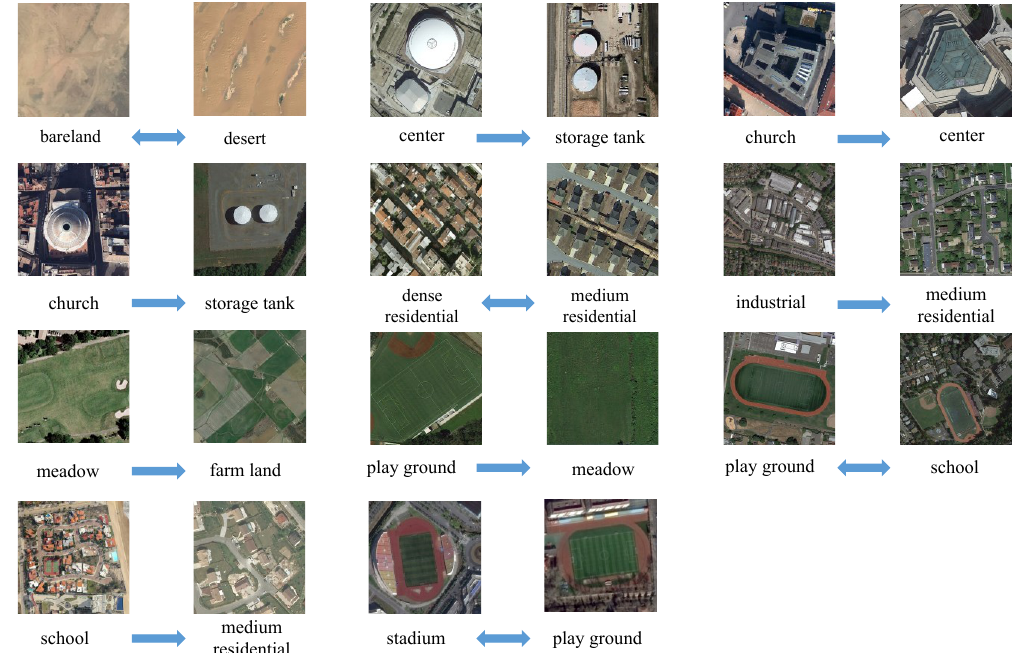
Figure 6. Examples of asymmetric noise mapping scenes in the AID dataset. Pseudo-Labeling noise : Pseudo-labeling methods can assign labels to unlabeled images automatically, which can reduce costs. However, there are not completely correct